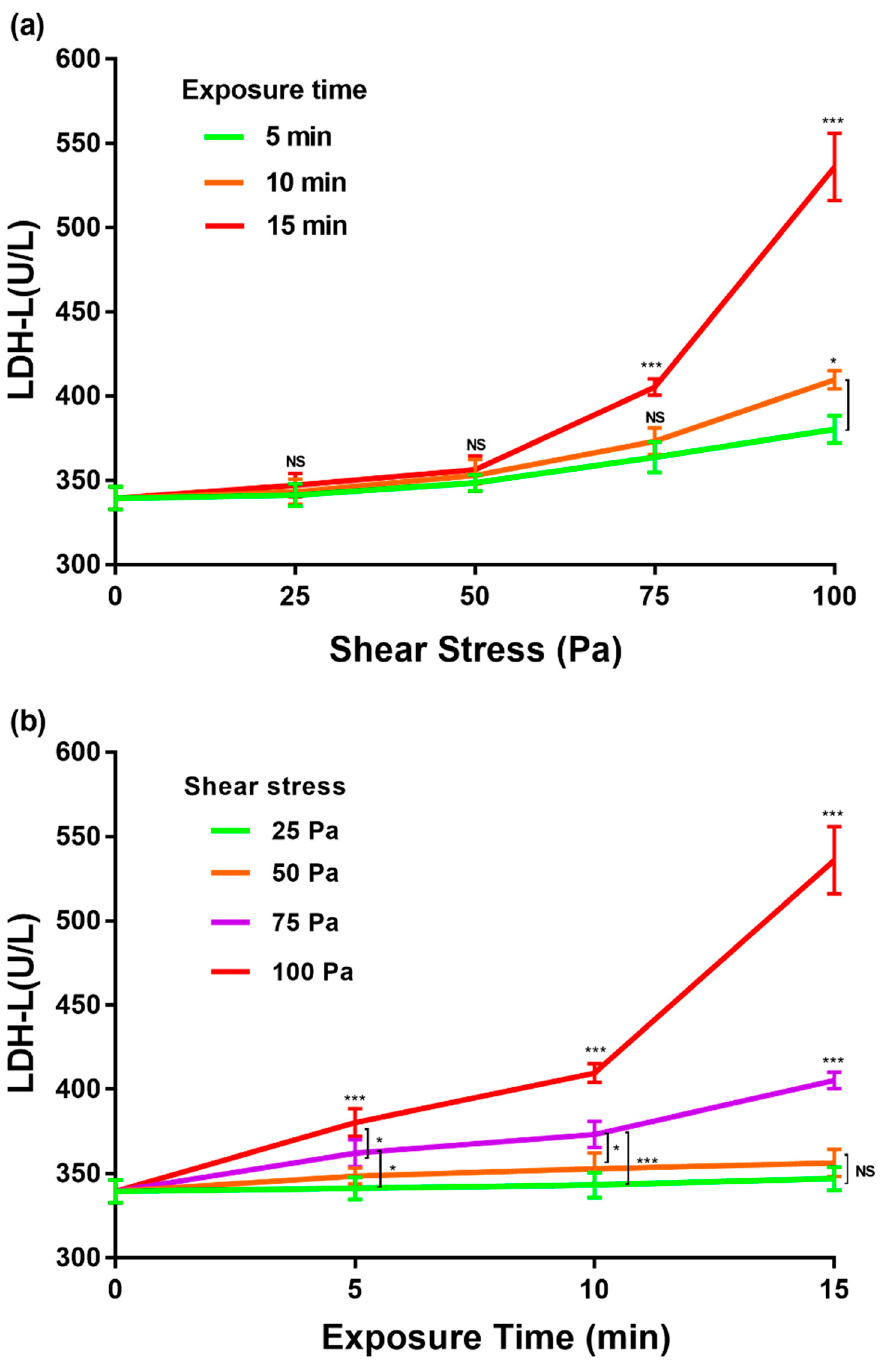
Figure 3. The changes of plasma lactic dehydrogenase (LDH) concentration under di ff erent shear stress and exposure times. ( a ) With the increase of shear stress, the concentration of plasma LDH showed an increase trend, especially above 50 Pa, the LDH release presented a rapid raise; ( b ) With the extension of the exposure time, the concentration of plasma LDH in 25 and 50 Pa shear stress environments rose slowly, but in an 100 Pa environment, showed a rapid increase.